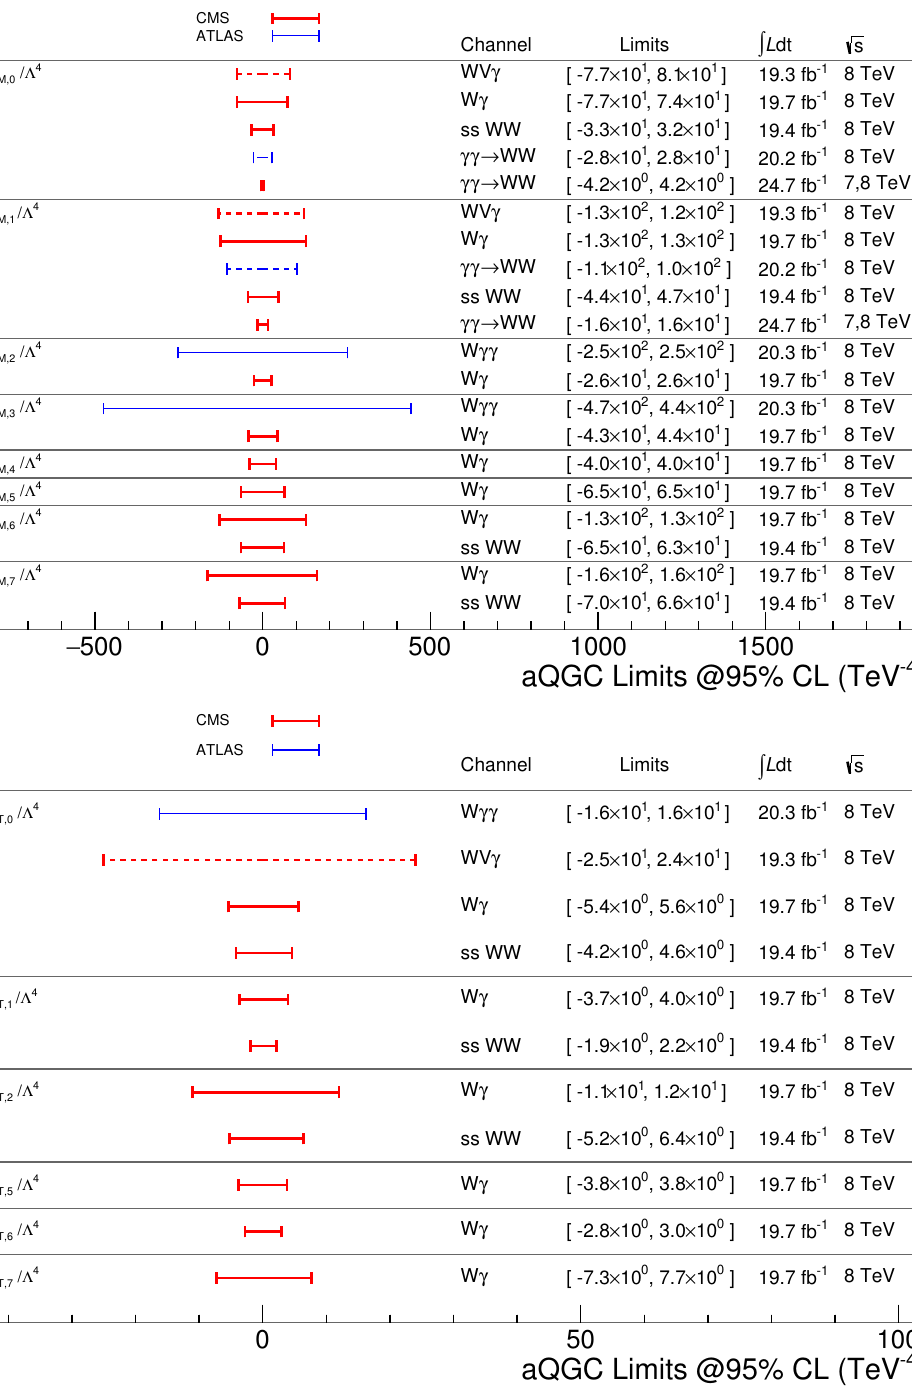
Figure 5 . Comparison of the limits on the dimension-eight aQGC parameters obtained from this study W (cid:13) , together with results from the production of WV (cid:13) [14], same-sign WW [17], exclusive (cid:13)(cid:13) ! WW in ATLAS and CMS [15, 19, 77], and W (cid:13)(cid:13) in ATLAS [30]. The limits from the CMS experiment are represented by thicker lines. The limits that are translated from another formalism are represented with dashed lines; details are found in ref.